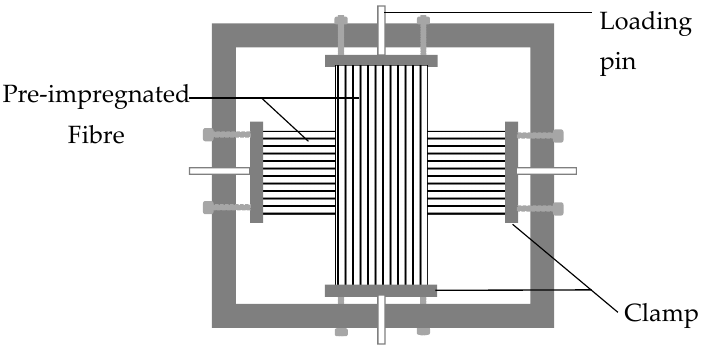
Figure 6. Schematic representation of biaxial loading frame. Zhao and Cameron, [44] utilised a fibre-prestressing rig similar to the biaxial loading frame to prestress glass fibre-reinforced polypropylene. The fibres are wounded on the frame and preloaded using the tensile testing machine, and then the bolts are locked to achieve the required prestressing level (Figure